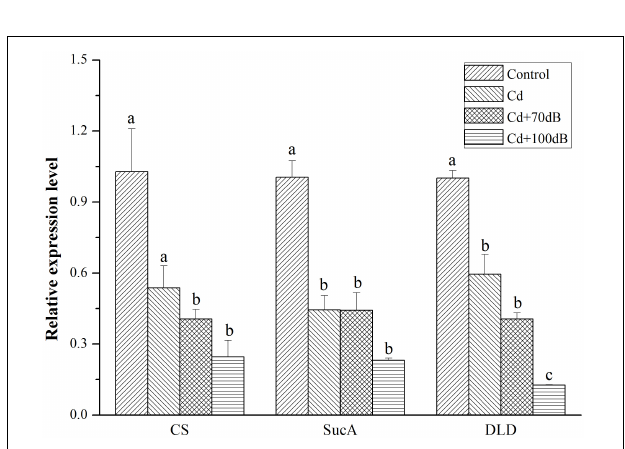
FIGURE 4 | Activities of acetylcholine esterase (AChE) in the tissues of the blood clams after 10 days of exposure to the control (without Cd and anthropogenic noise), 50 µ g/L Cd, 50 µ g/L Cd + 70 dB re 1 µ Pa anthropogenic noise, and 50 µ g/L Cd + 100 dB re 1 µ Pa anthropogenic noise. Means not sharing the same superscript are significantly different.